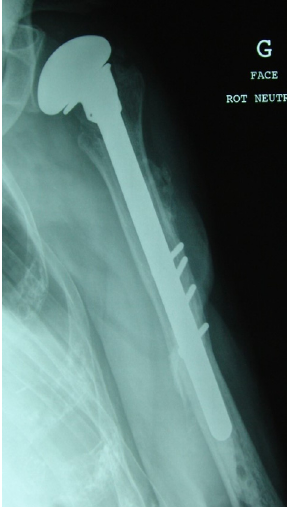
Figure 3. Immediate postoperative X-ray showing anatomical reduction of the fractures and good position of the prosthesis.